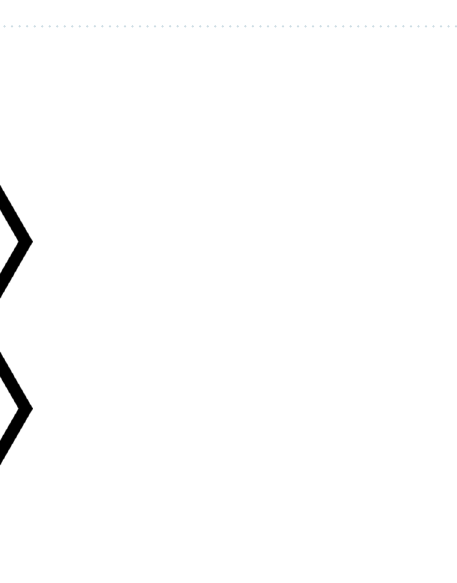
Figure 5. Abnormal growth of the large cylintrical 200-grain at the expense of the surrounding nanotwinned columnar grains.